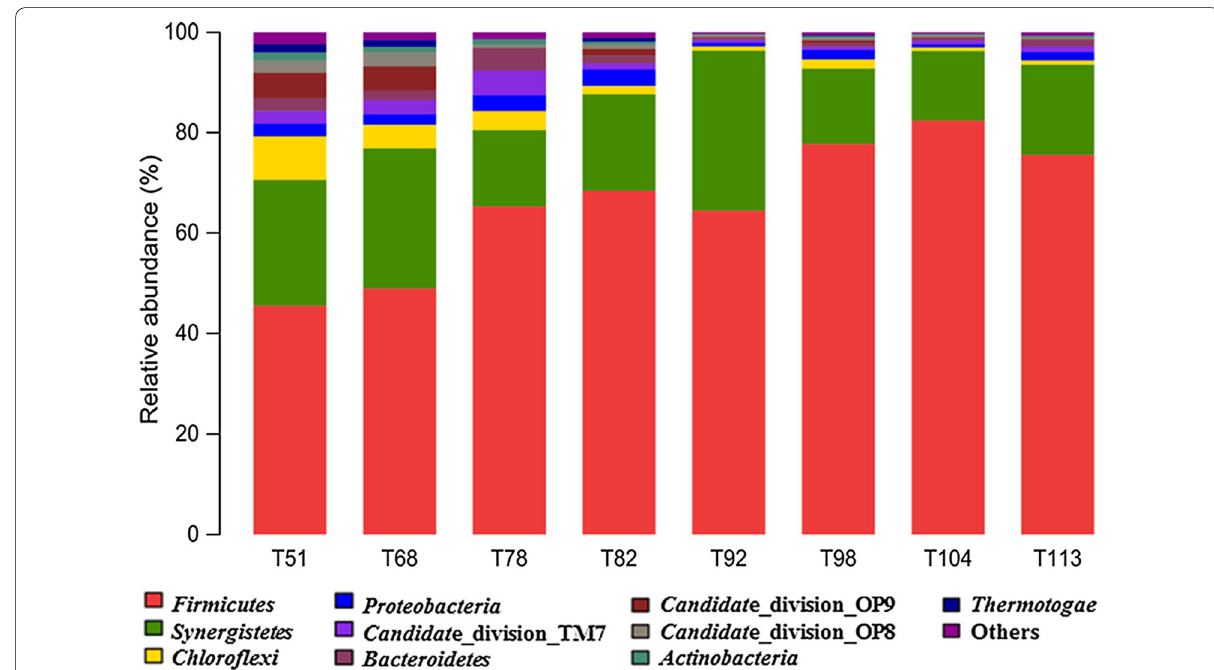
Fig. 2 Taxonomic compositions of bacterial communities at phylum level in each sample retrieved from pyrosequencing. The number in the sample names represented the day when sampling